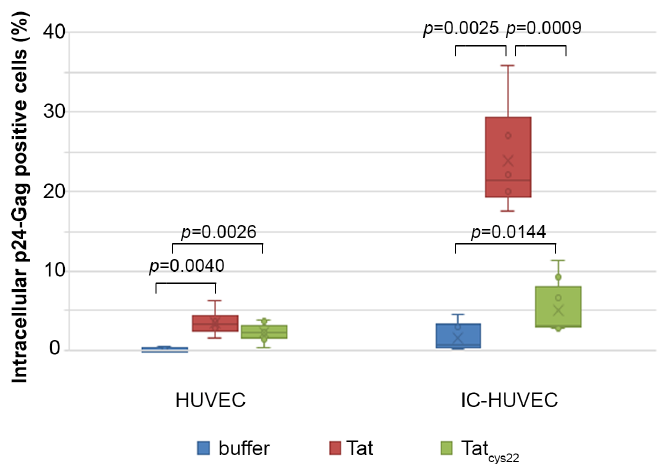
Figure 6. Extracellular Tat protein promotes productive Human Immunodeficiency Virus (HIV-1) infection of IC-HUVEC. HUVEC or IC-HUVEC were exposed to NL4.3 virus (p24-Gag = 70 ng/mL) in the absence or in the presence of 1 μM (10 μg/mL) of the Tat protein, either biologically active (Tat), or devoid of transactivating activity (Tat cys22 ). Four days later, cells were washed, trypsinized, and processed for intracellular staining for p24-Gag antigen. Box-plot data obtained from three independent experiments and analyzed by the Wilcoxon Two-sample Test are shown. Dots indicate individual measures.